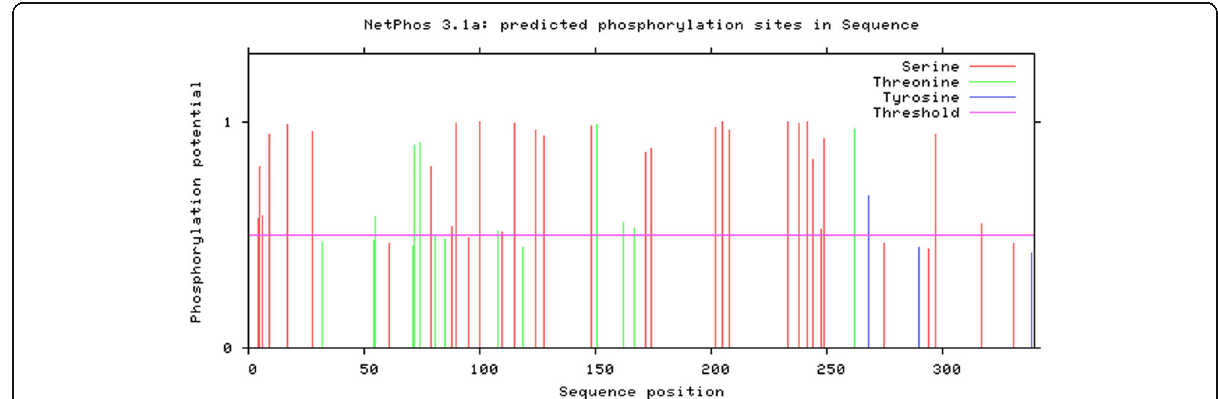
Fig. 6 Predicted phosphorylation sites in